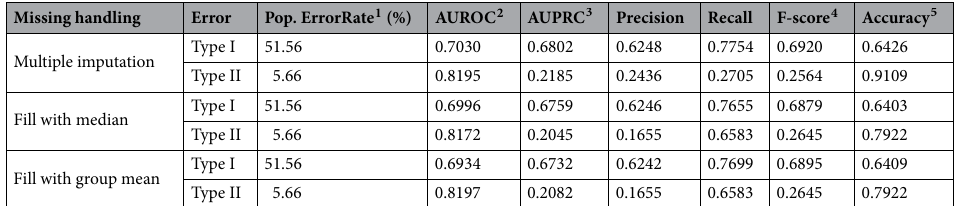
Missing handling Error Pop. ErrorRate 1 (%) AUROC 2 AUPRC 3 Precision Recall F-score 4 Accuracy